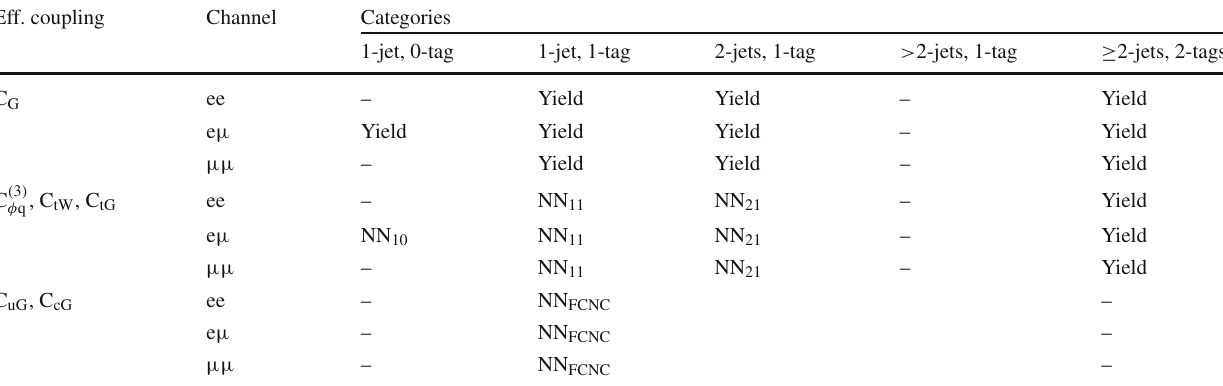
Table 3 Summary of the observables used to probe the effective couplings in various ( n -jets, m -tags) categories in the ee, e μ , and μμ channels Eff.